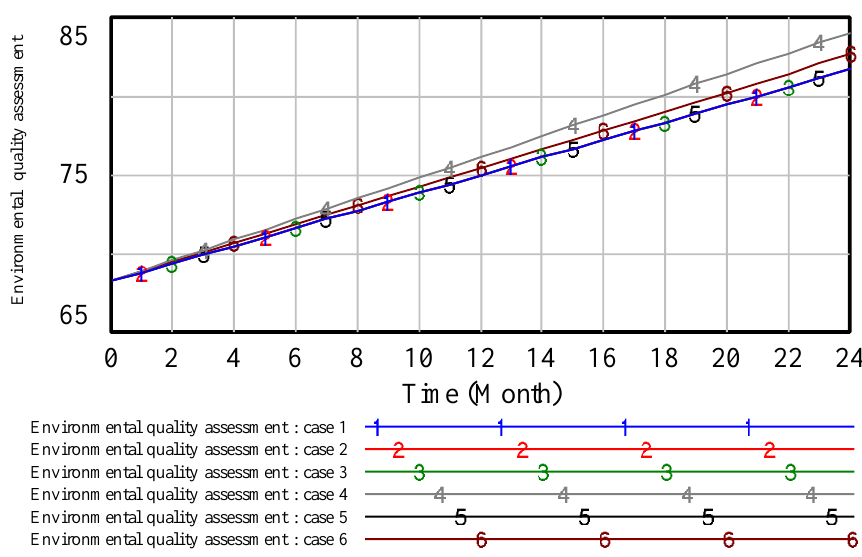
Figure 13. The simulation result of environmental quality assessment.